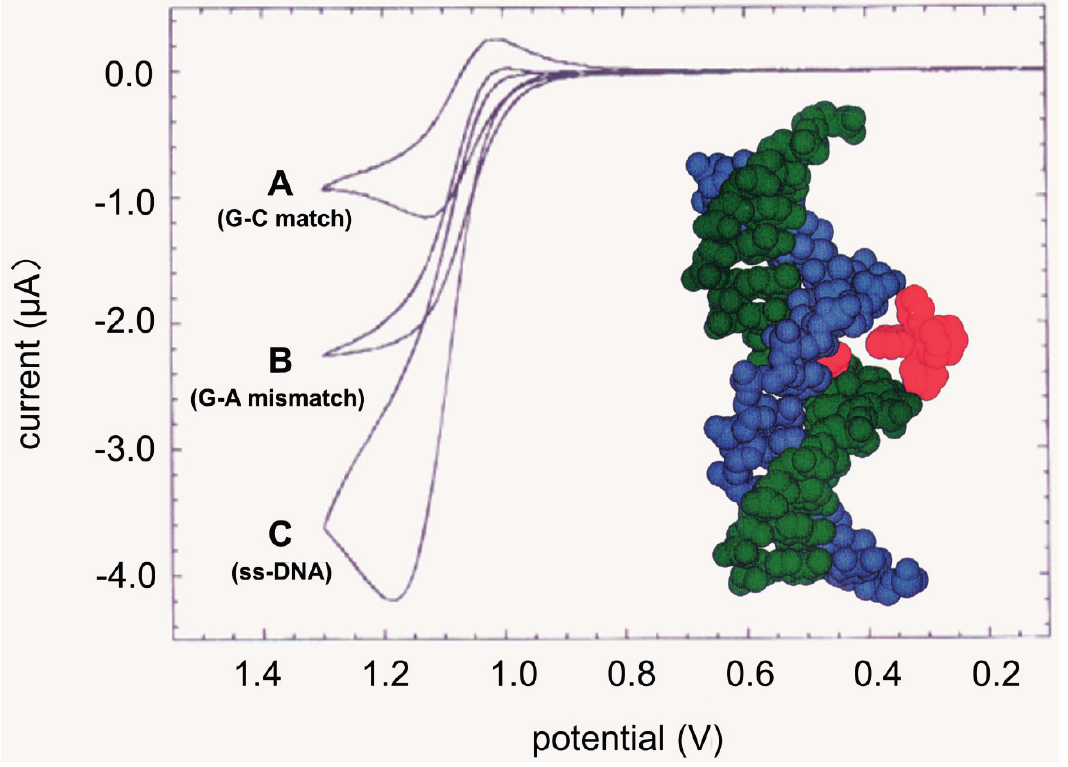
Figure 3. Using Ru(bpy) 32+ as a redox-active mediator to electrochemically distinguish native double helix, its single-base mismatch counterpart and the corresponding ssDNA from one another. Inset: computer model showing the interaction between Ru(bpy) 32+ and a guanine residue in a double helix (both in red). Adapted with permission from ref. [44], copyright (1995) American Chemical